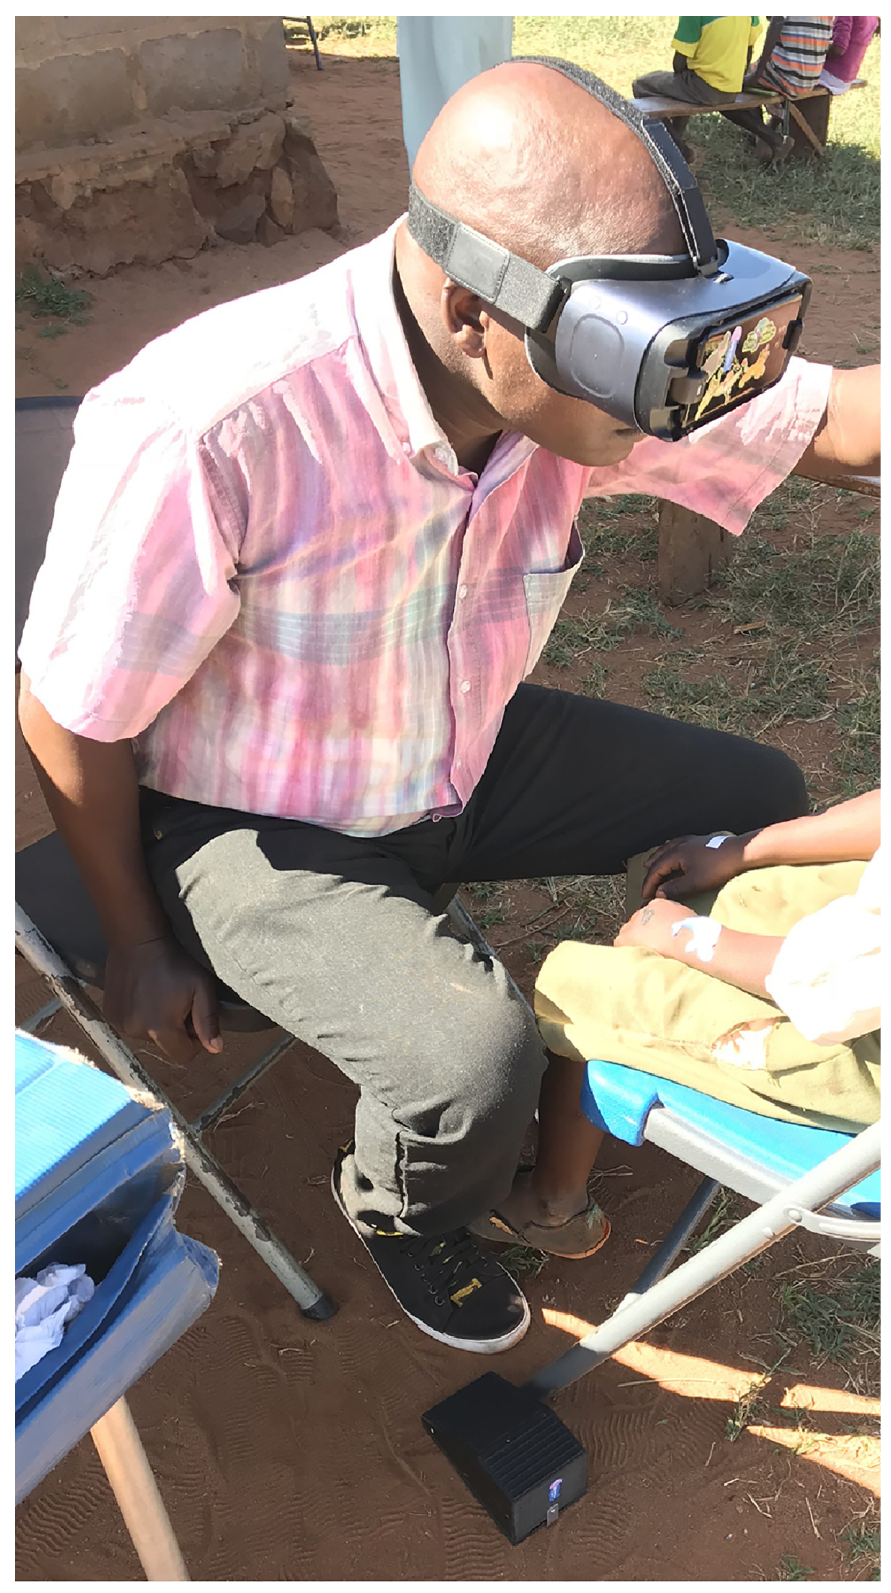
Fig 1. Samsung VR headset and Samsung Galaxy 8